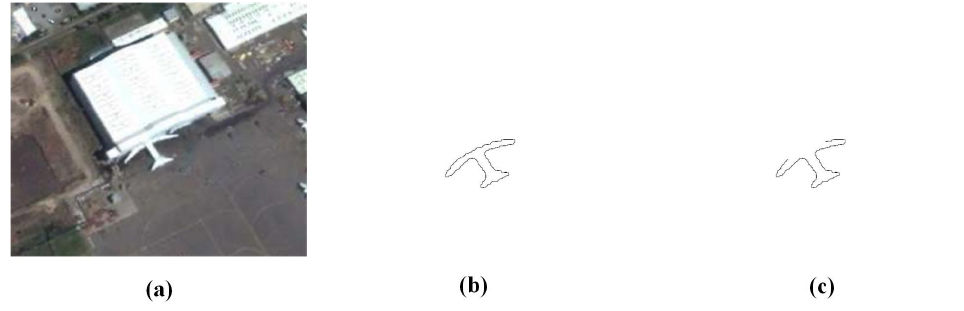
Figure 1. ( a ) The original image of the occluded aircraft target acquired by the remote sensing vision system, ( b ) the deformed contour obtained after the aircraft contour extraction, and ( c ) the missing local contour obtained after the aircraft contour extraction. As can be seen from the picture, the extracted target contours are not